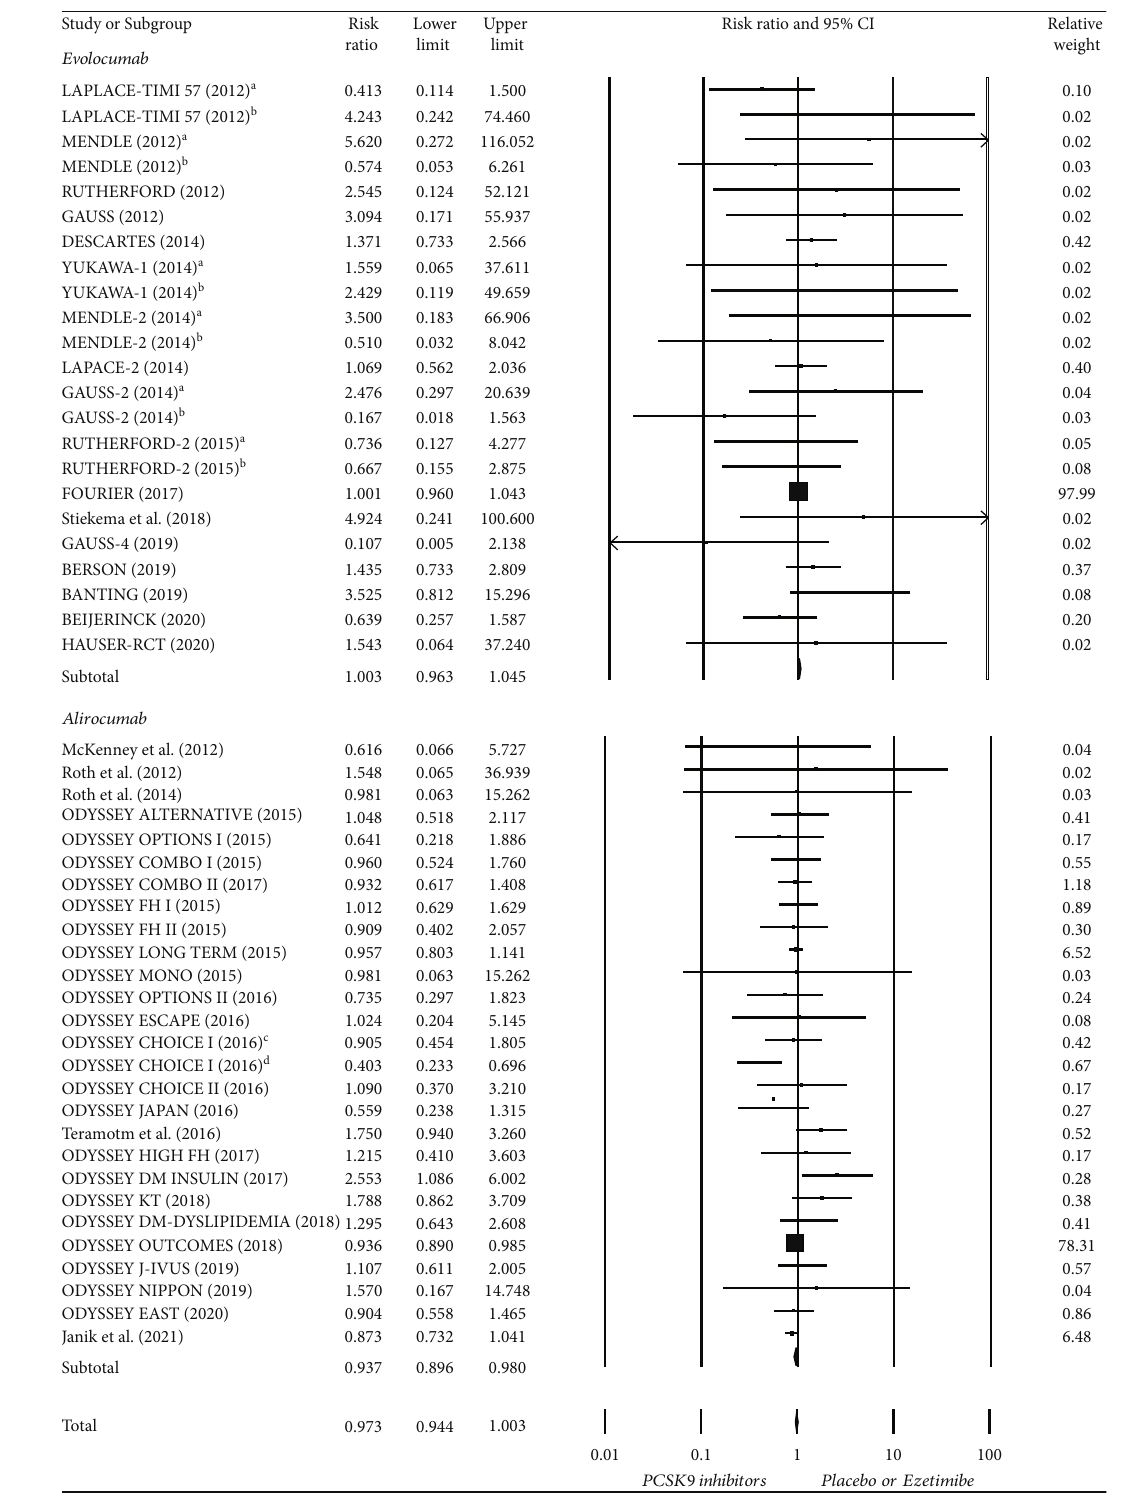
Figure 2: Forest plot of serious adverse events compared between PCSK9 inhibitors and control treatment (placebo or ezetimibe). a Treatment with evolocumab Q2W; b Treatment with evolocumab Q4W; c Treatment with alirocumab Q2W; d Treatment with alirocumab